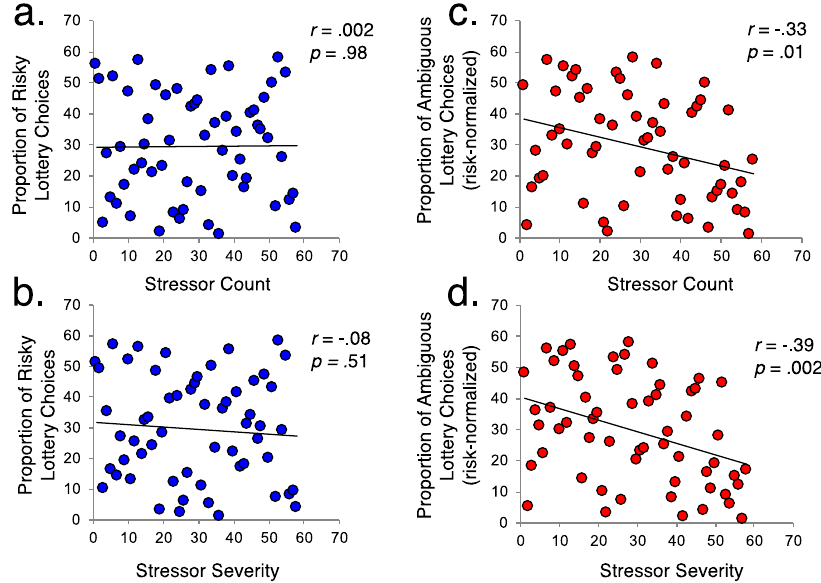
Fig. 3 Effect of lifetime stressor exposure on estimates of risk and ambiguity tolerance (Study 1). Scatterplots depicting participants ’ proportion of risky lottery choices (blue) plotted separately for total lifetime stressor a count and b severity, and proportion of ambiguous lottery choices (red) plotted separately for total lifetime stressor c count and d severity. A signi fi cant negative association emerged between both STRAIN indices and ambiguous lottery choices, indicating that greater lifetime stressor exposure was associated with less tolerance for ambiguity, while no such association was observed for risky lottery choices. Scatterplots depict non-parametric correlations (Spearman ’ s